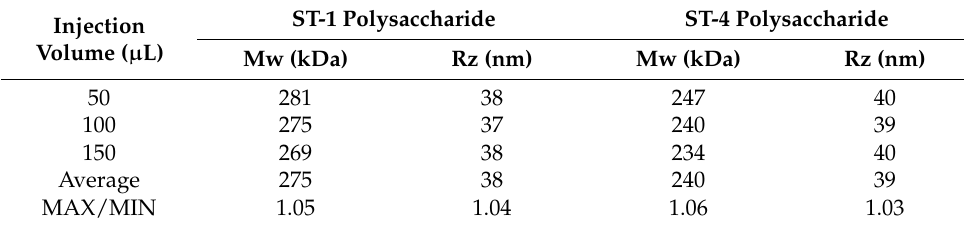
Table 2. Mw and Rz for unconjugated polysaccharides on